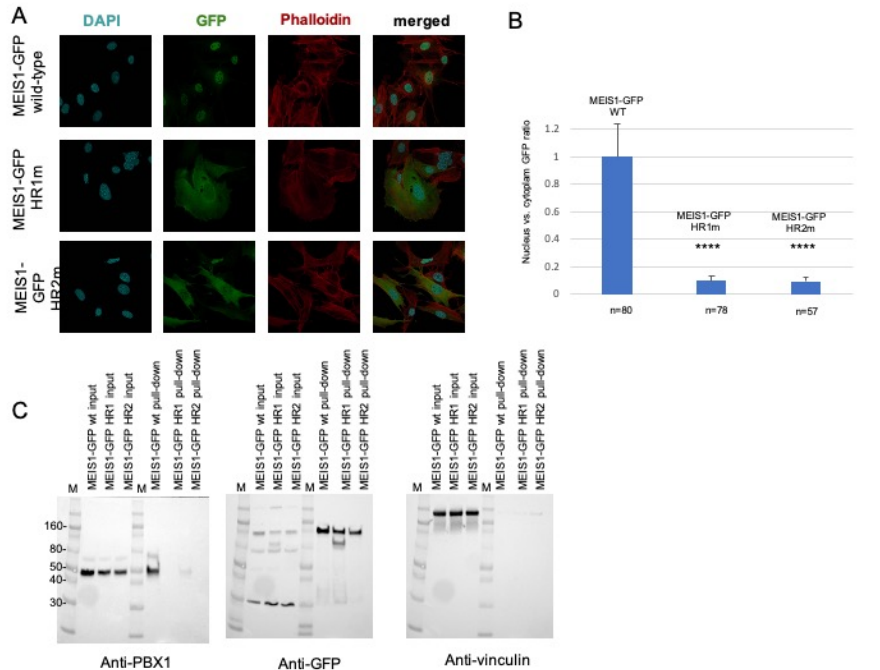
Figure 2. Mouse embryonic fibroblasts were transfected with a plasmid encoding wild-type or mu- tant MEIS1-GFP (HR1m is the MEIS1-GFP mutant L83A/L86A/L87A/I90A; HR2m is the MEIS1-GFP mutant I149A/L152A/L156A/L159A). Panel ( A ): The figure shows illustrative confocal immunoflu- orescence microscopy images in which the nucleus is identified by DAPI fluorescence and MEIS1 by GFP immunofluorescence. The transfected constructs are indicated at the left of the images. MEIS1-GFP is in green, DAPI in blue, and phalloidin in red. The merged DAPI, red, and GFP chan- nels are shown in the right panels. MEIS1-GFP HR1 and HR2 mutants reveal a cytoplasmic locali- zation, compared to the exclusively nuclear localization of wild-type MEIS1-GFP. Panel ( B ): Bar graphs showing the intracellular distribution of wild-type and mutants MEIS1-GFP. Plotted is the percentage of the total signal in each compartment, using measurements from between 57 and 80 individual cells for each construct. Only cells expressing MEIS1-GFP were included in the total counts and used to calculate percentages. Panel ( C ): pull-down experiment from total lysates. On the left, blotted with anti-PBX1 antibody, the inputs of the three total lysates of MEFs overexpressing wild-type MEIS1-GFP, and the two HR1 and HR2 mutants, along with the pull-down result. In the middle, the same membrane, blotted with anti-GFP antibody, to control the efficiency of the pull- down; on the right, the same membrane blotted with anti-vinculin, to control the loading of the input. M is the molecular weight standards, and some reference markers are annotated on the left side of the membrane. We indicate with **** values below 0,005 (99% significance).